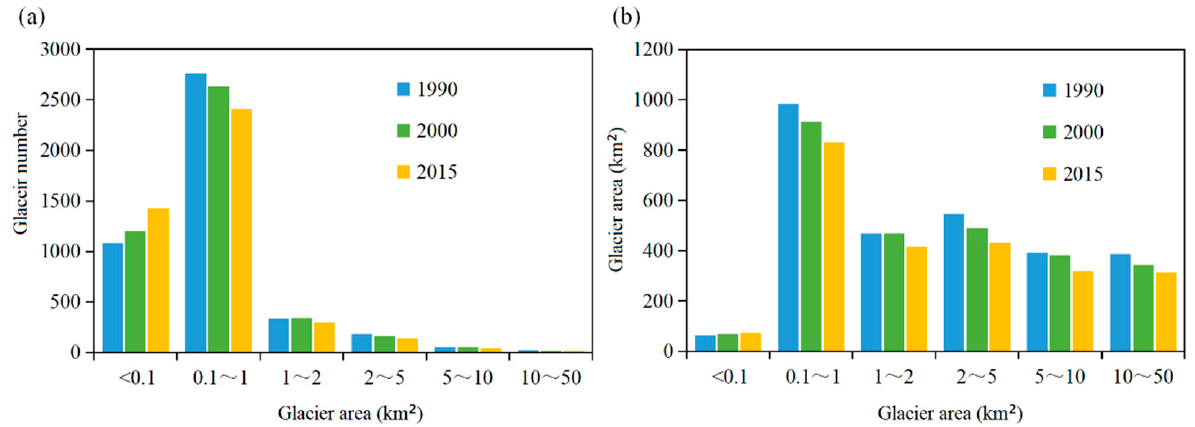
creasing by 19.23%.